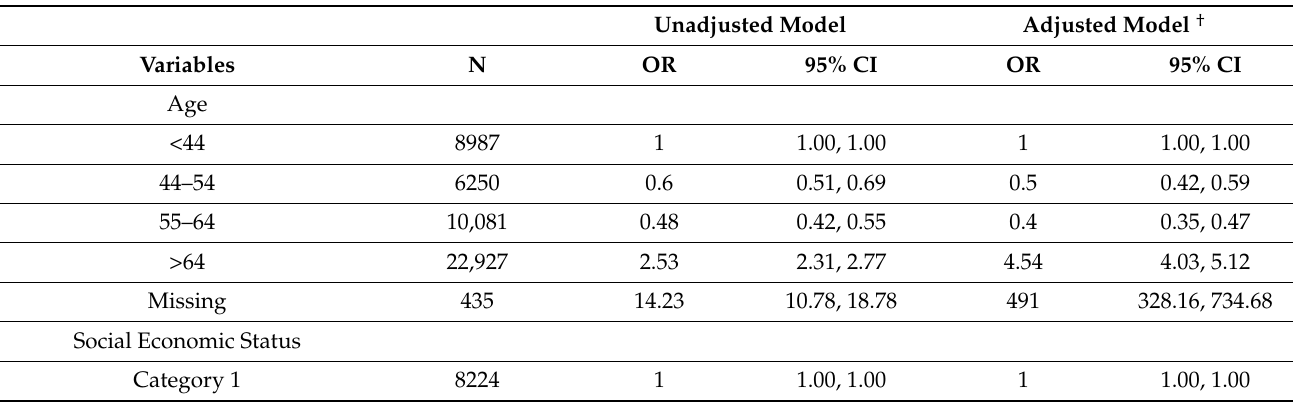
Table 5. Unadjusted and adjusted associations between dropout at HCV RNA testing stage and socio-economic, demographic, clinical, behavioral, and hospital characteristics